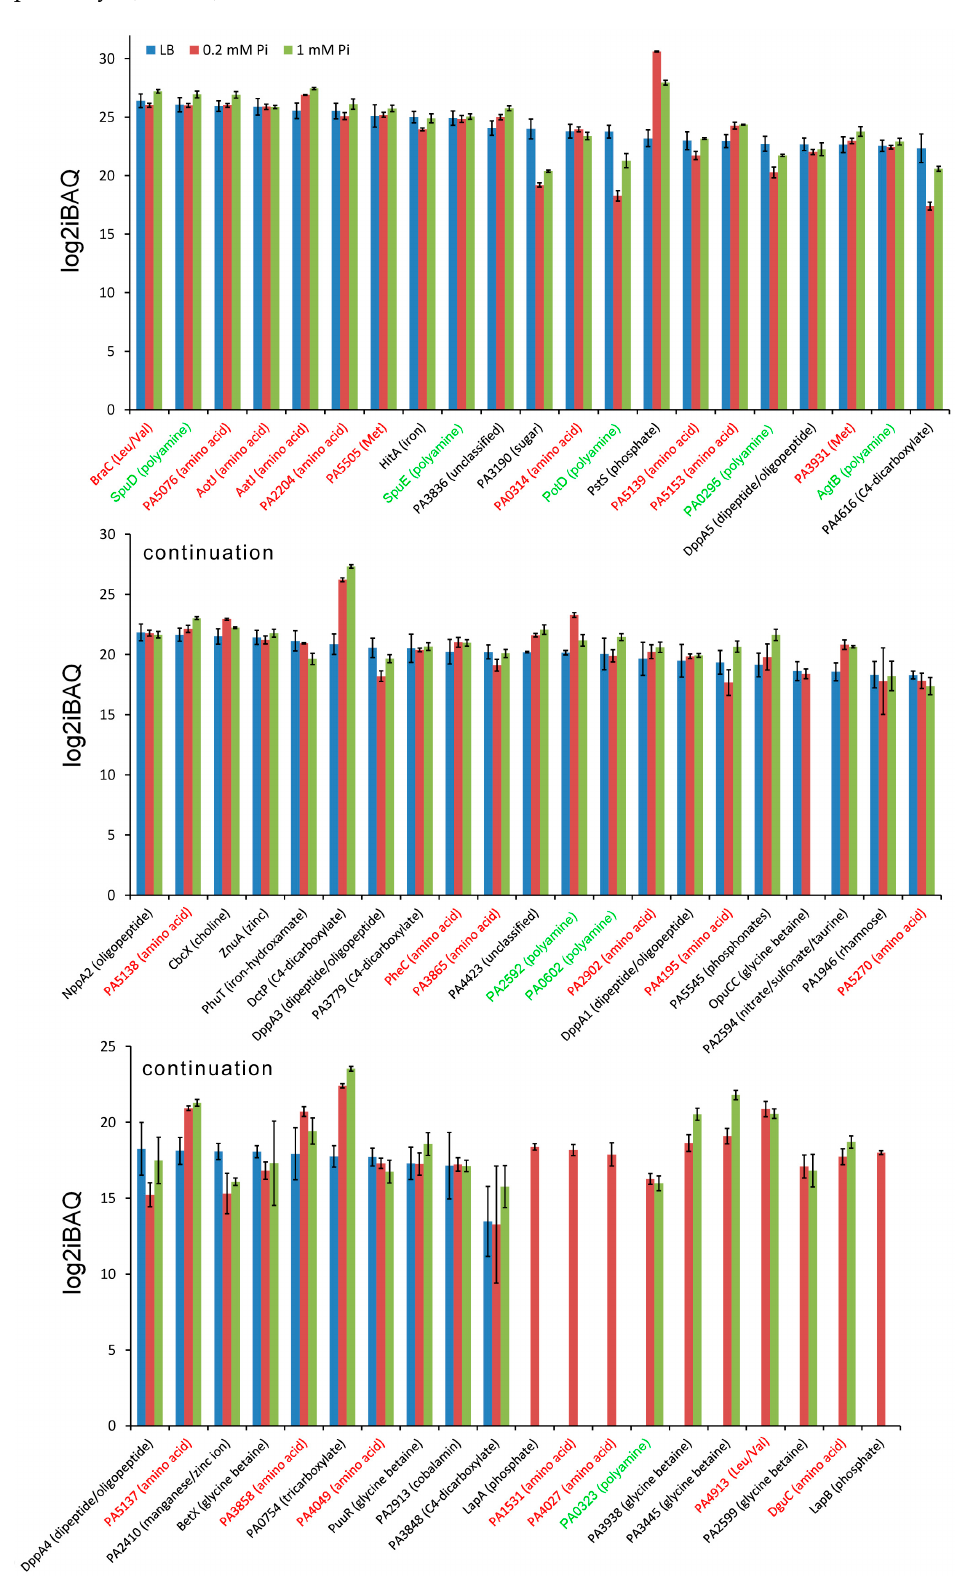
Figure 8. Relative abundance of solute binding proteins in P. aeruginosa PAO1 grown in LB medium or minimal medium with 0.2 mM and 1 mM Pi. Proteins were ordered according to their protein amount in LB. The ligands for these proteins were predicted by Transport DB [94]. The experimental determination of ligand profiles for P. aeruginosa PAO1 solute binding proteins largely confirms